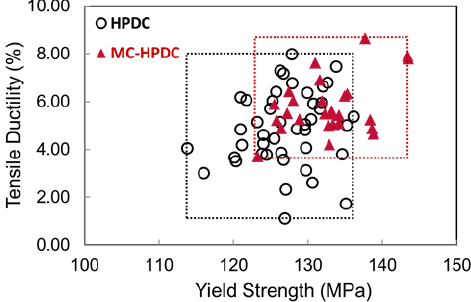
Figure 7. Yield strength and tensile ductility of die-cast AZ91D alloy specimens produced with (MC-HPDC) and without (HPDC) melt shearing. Dotted lines show the range of the respective properties. Reprinted with permission from Ref. [44]. Copyright 2022, Elsevier.